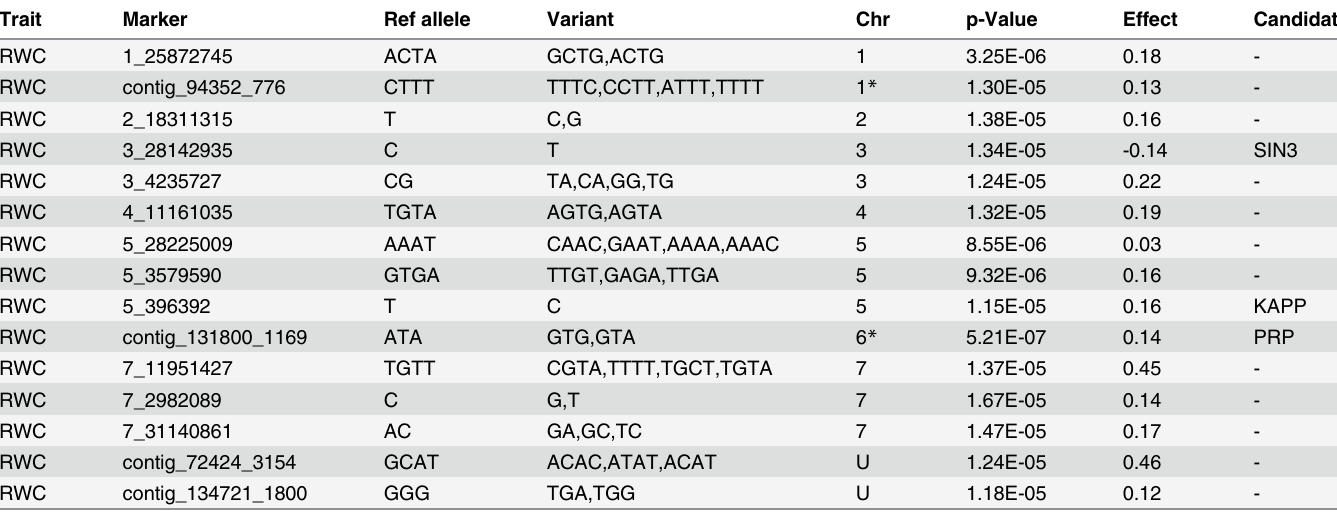
Table 4. Most significant SNP markers associated with leaf relative water content (RWC) in alfalfa. Trait